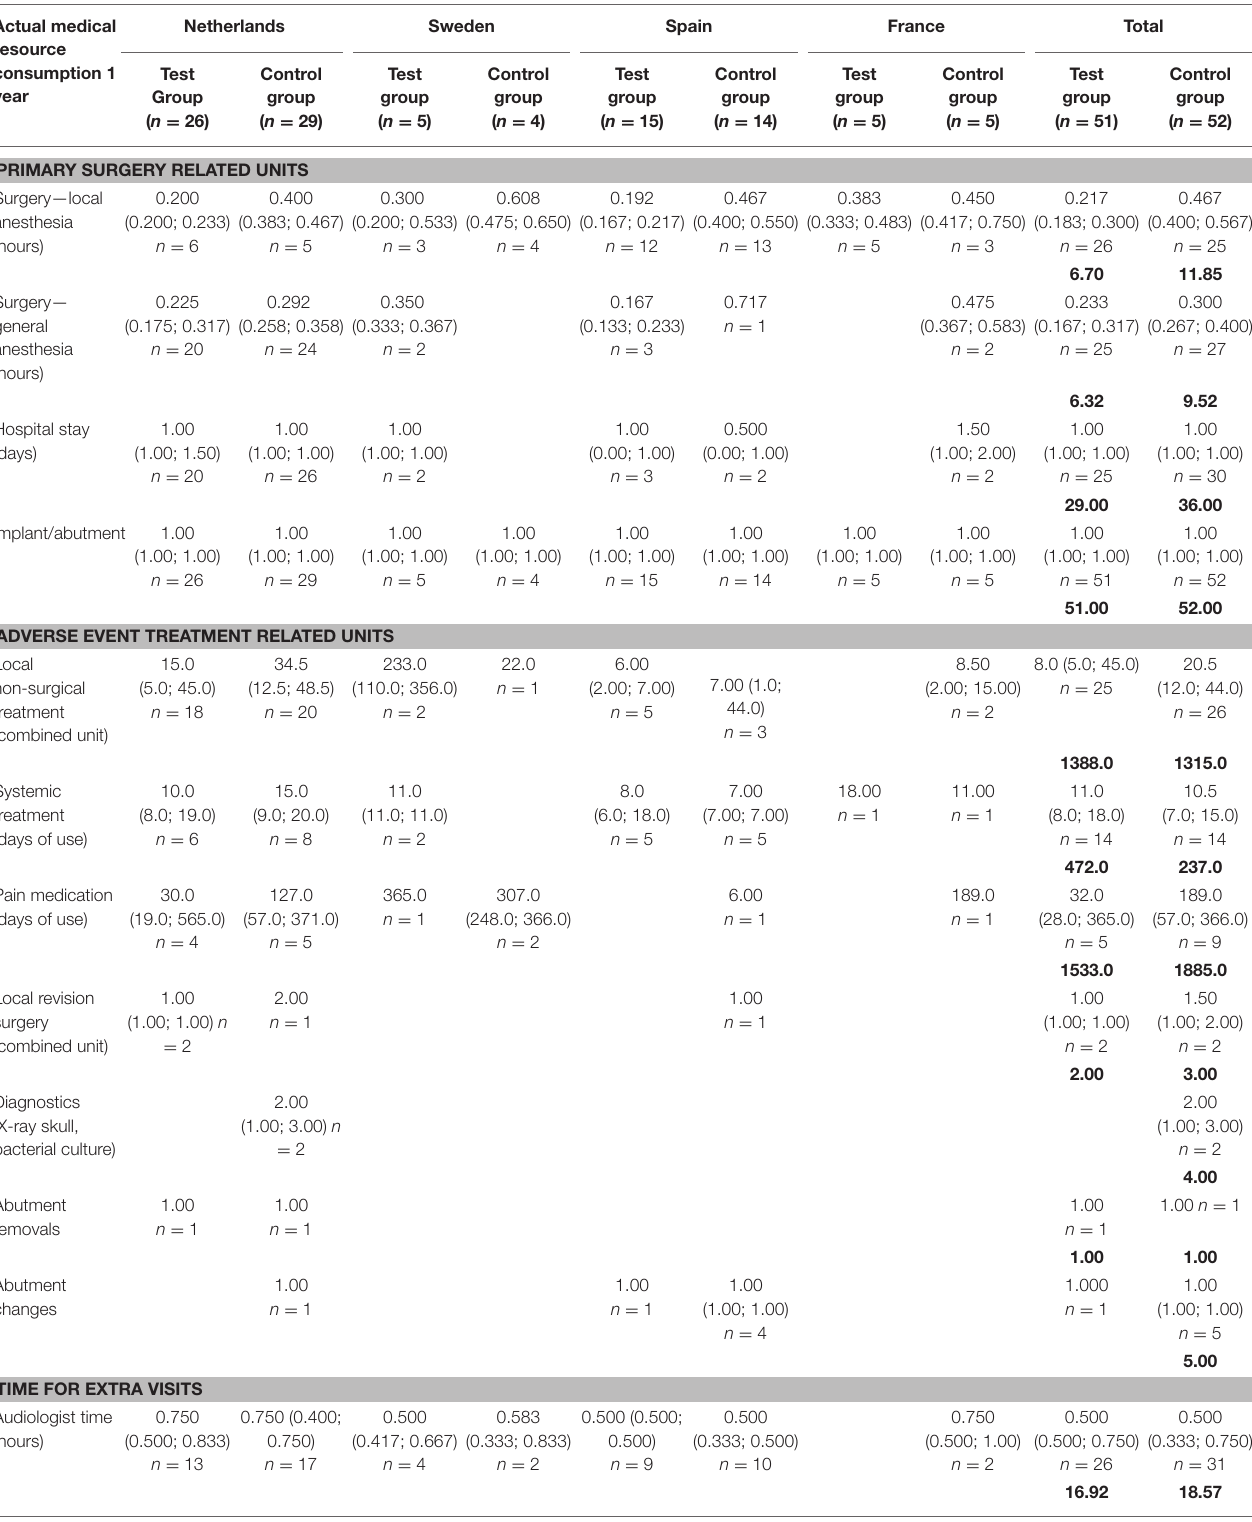
TABLE 2A | Units per country after 1